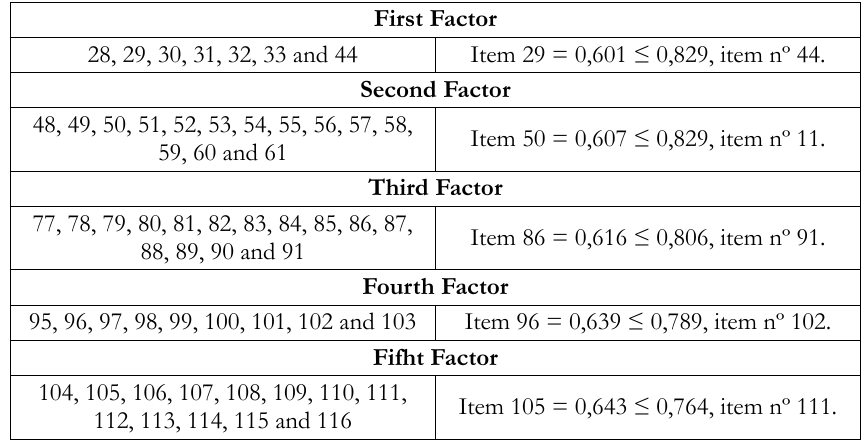
Table 1. Factors that define the